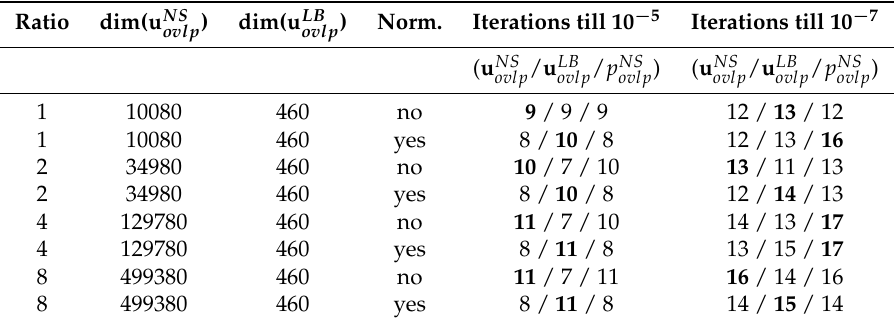
Table 2. Influence of the ratio, and of the normalization on the convergence behavior of the Anderson accelerated coupling. All runs use u NS and u LB as primary variables, and p NS as a secondary ovlp ovlp ovlp variable. The mesh is coarsened by a factor of two compared to the results in Table 1. The bold numbers in columns 5,6 correspond to the absolute number of coupling iterations (maximum of the given iteration numbers for each coupling variable) to reach convergence. dim(u NS ) dim(u LB ) ovlp ovlp